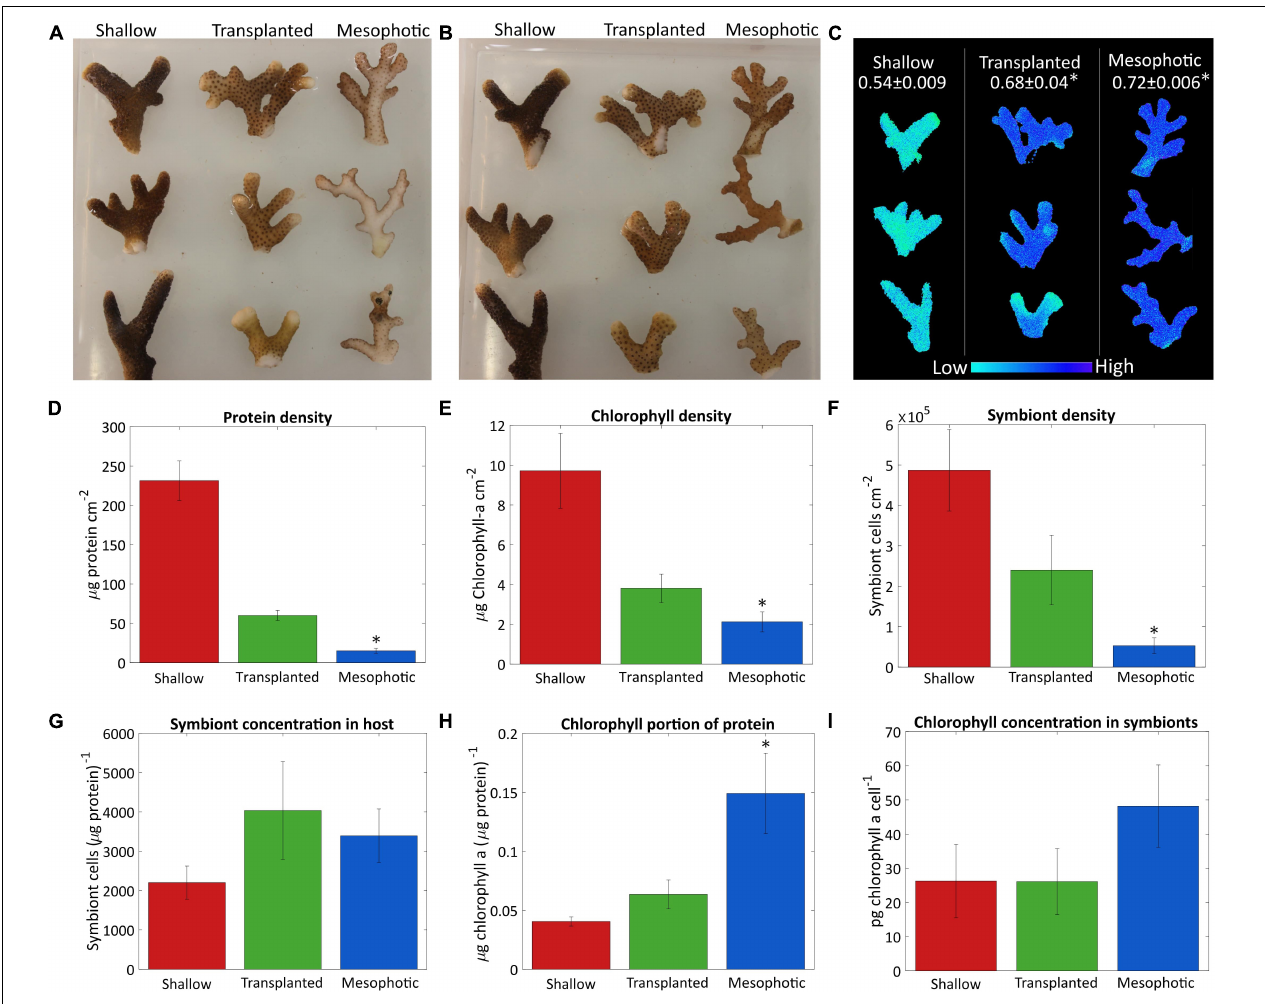
FIGURE 1 | Algae coverage and chlorophyll content. Three fragments from each colony were sampled after 18 months from the shallow corals (red), transplants from mesophotic to shallow (green), and mesophotic corals (blue). Photos of (A) the upper side of the fragments which faces the water surface and (B) the bottom side of the fragments, which faces the seabed. (C) Maximal photosystem II quantum yield ( F v / F m ) obtained by Imaging-PAM, measured on the upper side of the fragments. Average values for each colony are given at the top. (D) Total protein per surface area. (E) Surface density of chlorophyll a . (F) Number of symbiont cells per area. (G) Number of symbiont cells per total protein. (H) Chlorophyll a ratio to total protein. (I) Cellular chlorophyll a concentration in the symbiont cells. Error bars of (D–I) showing the standard error of the mean, n = 4. Asterisks (*) indicate statistical differences relative to shallow